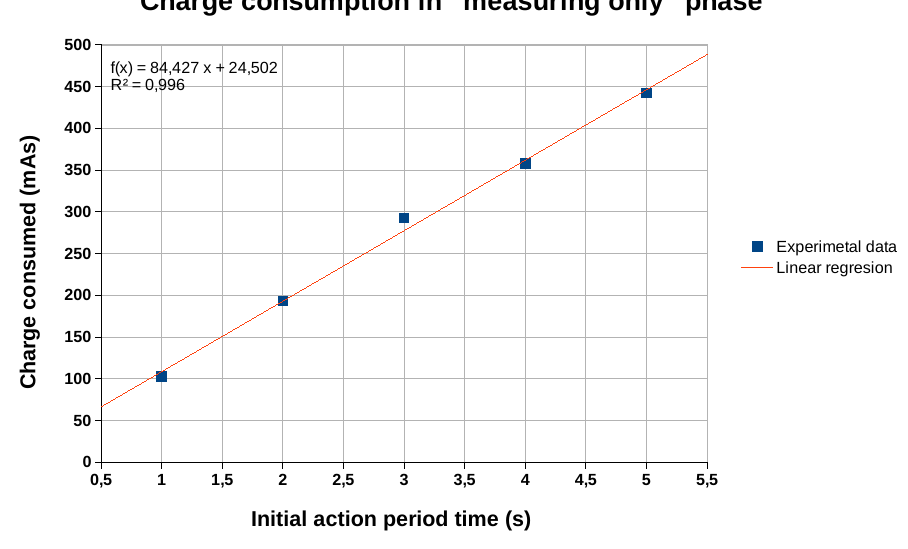
Figure 13. Charge consumed in the “measuring-only” state, as a function of the measurement time ( t meas